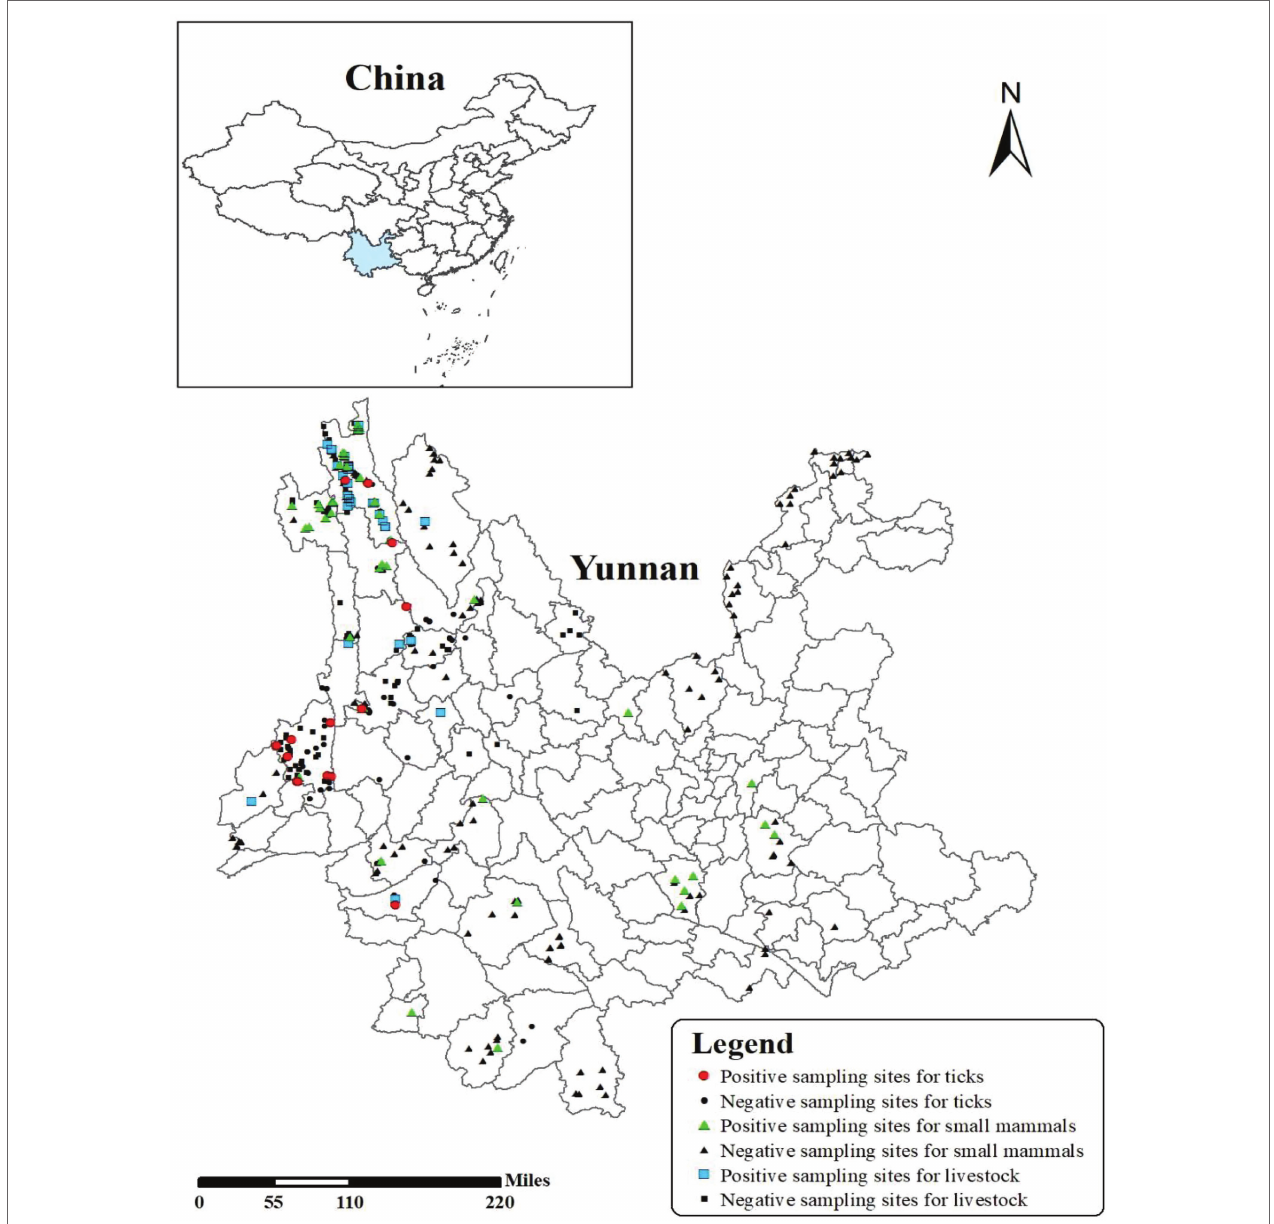
FIGURE 1 | The distribution of sampling sites and prevalence of Borrelia burgdorferi sensu lato in Yunnan Province. Small mammals/live stocks/ticks were collected from 40 sample counties, including 21 positive sample counties (Tengchong, Deqin, Weixi, Gongshan, Shiping, Yongde, Fugong, Lanping, Gengma,